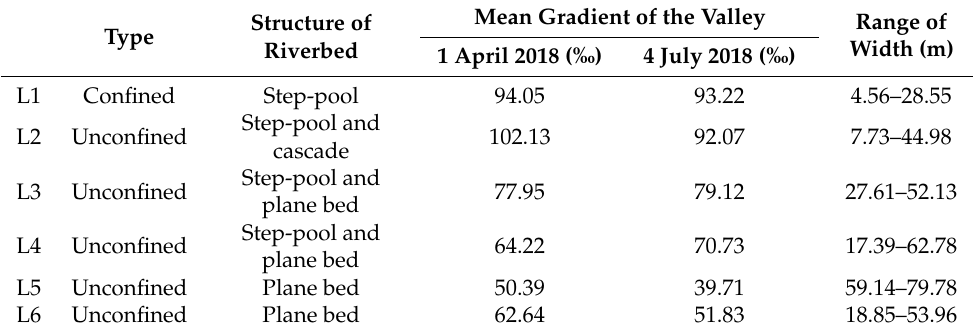
Table 1. Characteristics of different parts.